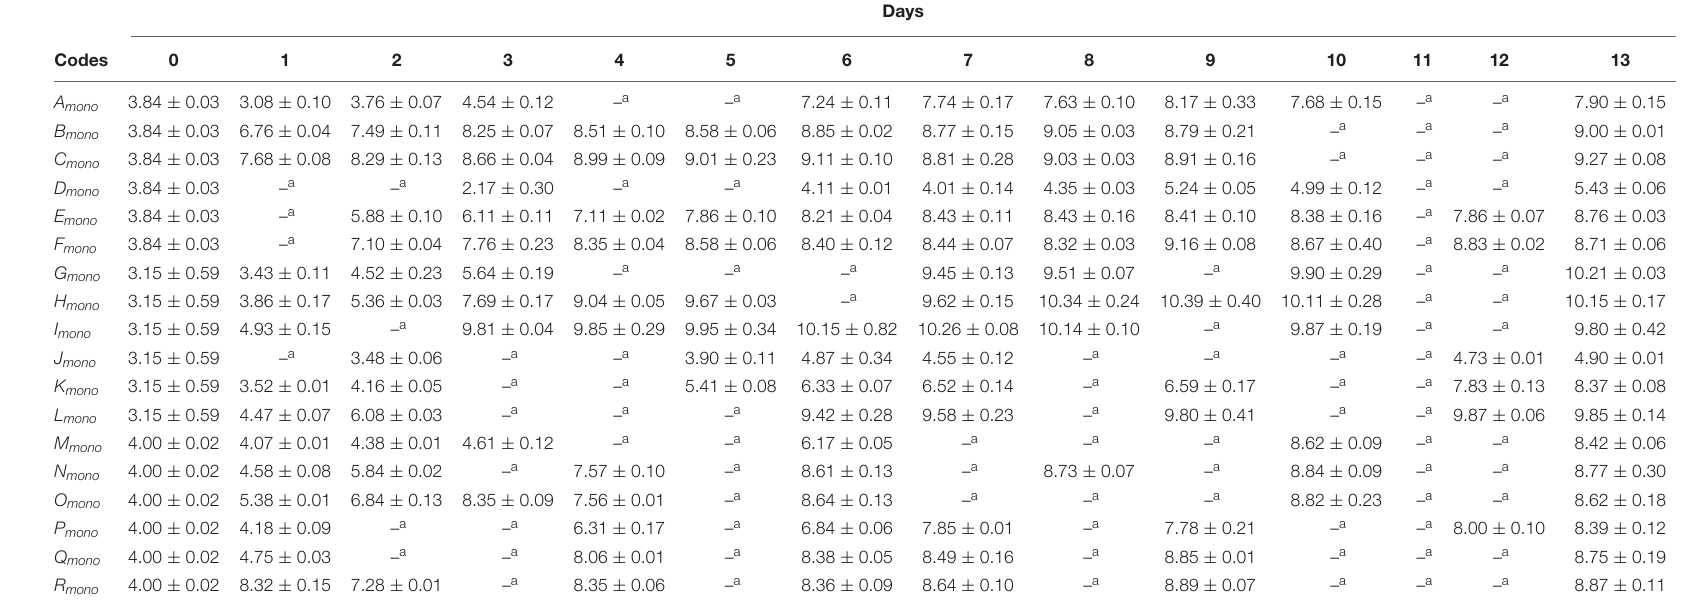
TABLE 2 | Microbiological counts (log CFU/g) for mono-culture experiments in minced pork samples stored during 13-days shelf life, at constant temperature, in food wrap (FW) and modified atmosphere packaging (MAP, CO 2 30%/O 2 70% ±